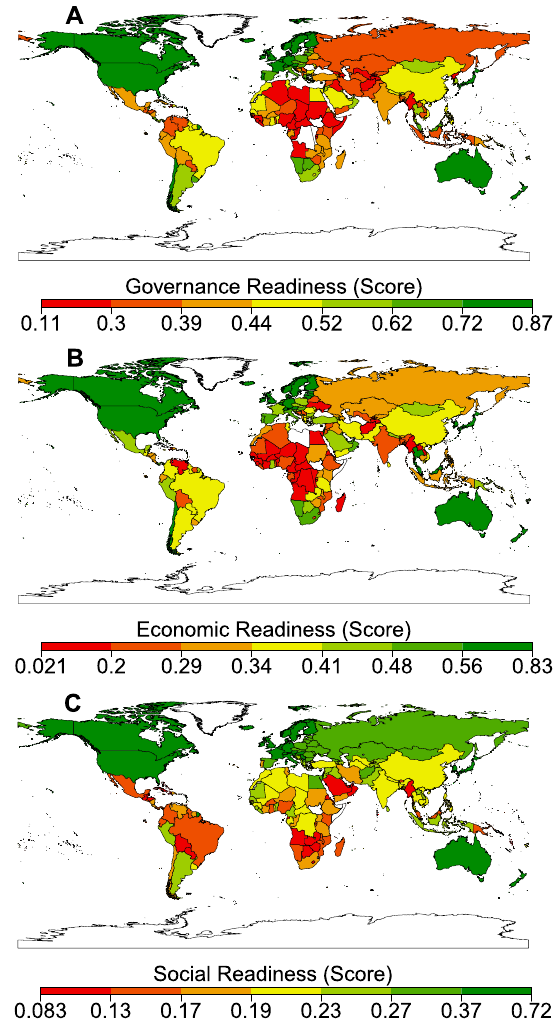
Fig. 4 Mitigation of climate change (A) Governance Readiness (B) Economic Readiness (C) Social Readiness. From red to green denotes low to high readiness. The method of country-level data categorization was based on quantiles, used to capture continuous intervals with uniform distribution. A — mean: 0.50, min: 0.08, and max: 0.88, ( N = 188); measured in scores, dimensionless. B — mean: 0.39, min: 0.03, max: